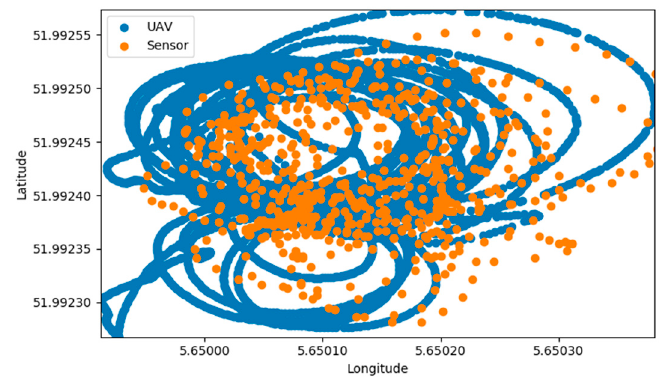
Figure 3. Latitude and Longitude coordinates plot of the UAV and Sensor’s GPS, indicating much lower resolution of the sensor.